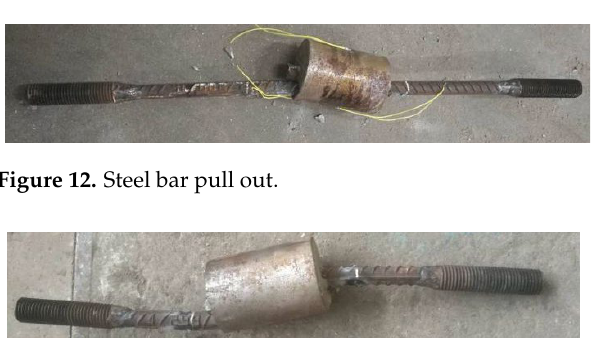
Figure 13. Steel bar bending after repeated tension and compression loading.